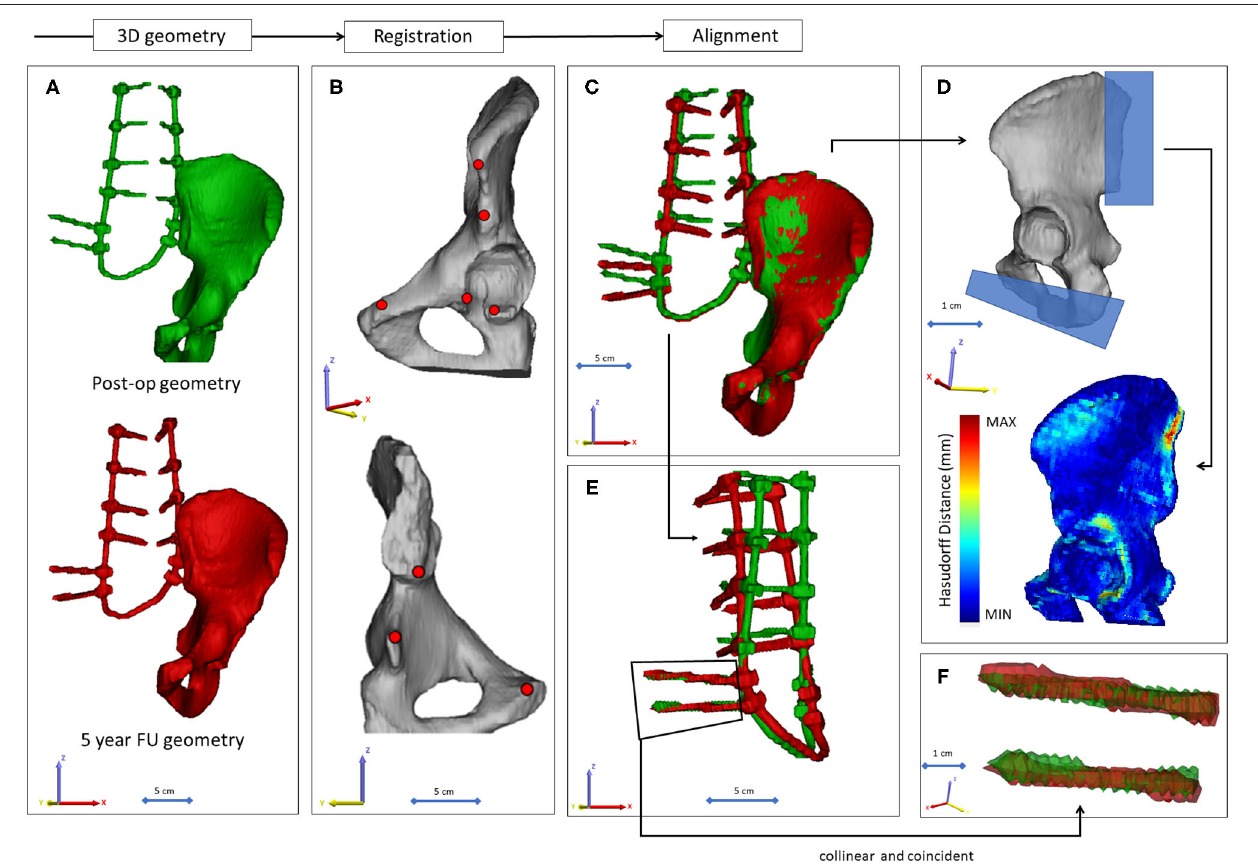
FIGURE 3 | Post-op CT scan-based geometry definition and alignment. (A) Thresholding based segmentation was performed on the postop CT scans in order to define the left pelvic bone and the implant construct. (B) Eight points corresponding to anatomical landmarks were used for the simultaneous registration of the